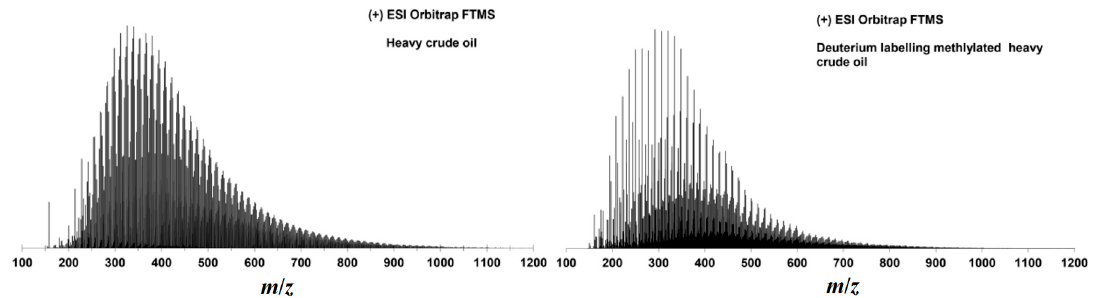
Figure 3. ESI(+) Orbitrap FTMS mass spectrum of heavy crude oil ( left ) and deuterium labeling methylated heavy crude oil ( right ).